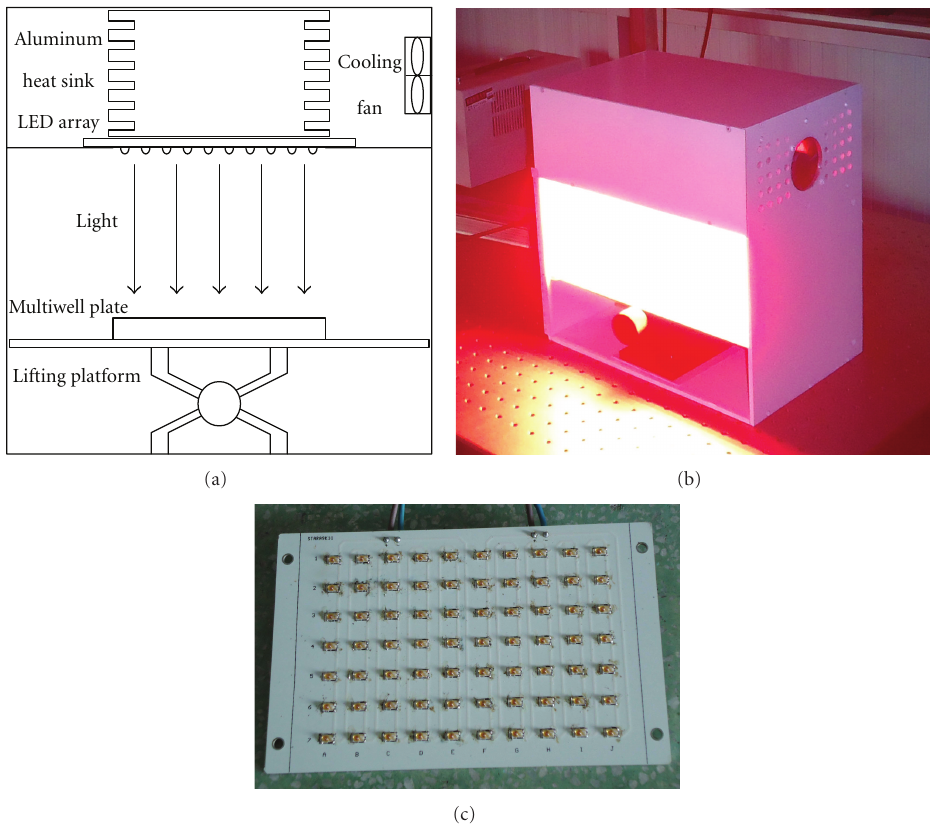
Figure 1: (a) Schematic diagram of the red LED based illumination system. (b) Photograph of the red LED based illumination system for PDT studies. (c) Prototype of the 10 × 7 LED